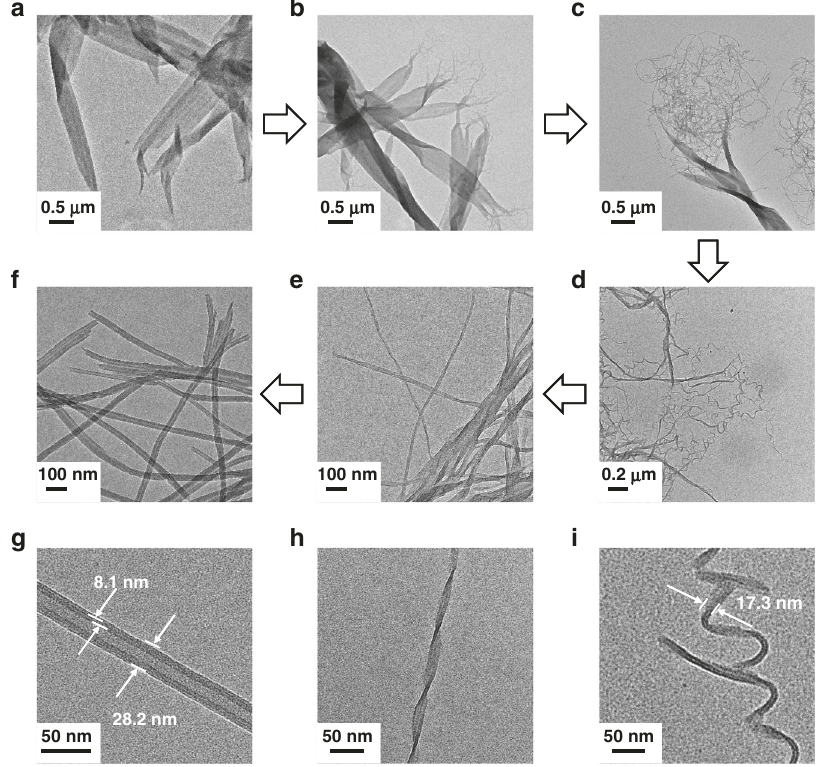
Fig. 2 Time evolution of morphological nanostructures of 1-R from nanoribbons to nanotubes. Transmission electron microscopy (TEM) images showing the transformation from nanoribbons to nanotubes during self-assembly of 1-R . The initially formed nanoribbons ( a ) (5 min) begin to develop split ends ( b ) (10 min) and dissociate further ( c ) (30 min) to form nanocoils ( d ) (1 h), which are transformed to twisted nano fi bers ( e ) (3 h), and eventually to nanotubes ( f ) (5 h). g – i TEM images of individual nanotube ( g ), nanohelix ( h ), and nanocoil ( i ). Self-assembly condition: 27 μ M of 1-R in 10% CHCl 3 /EtOH, 65 °C (clear solution) to 15 °C in a temperature-controlled cell, cooling rate: 10